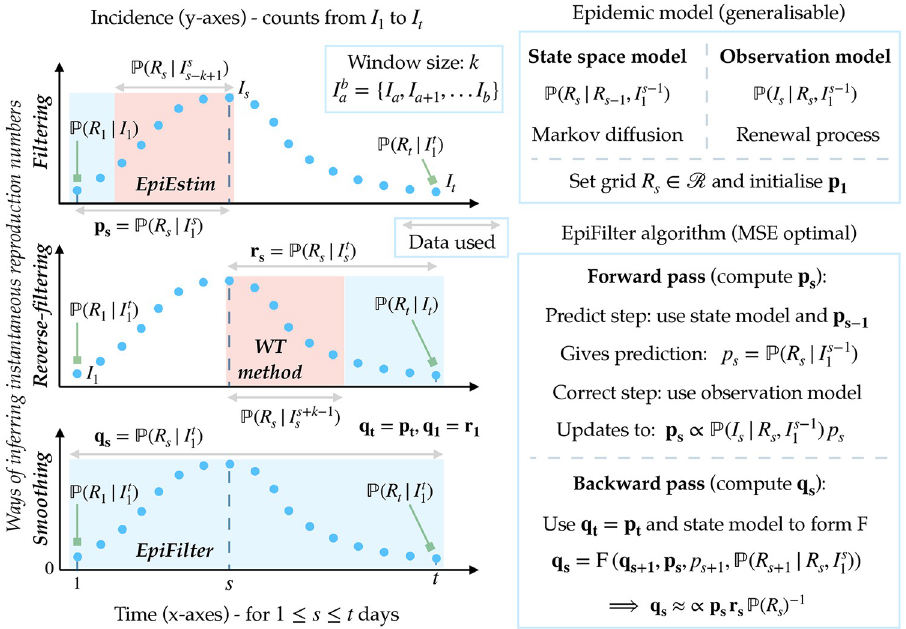
Fig 1. EpiFilter algorithm and relationship to other methods. In the left panels we consider three ways of inferring the instantaneous or effective reproduction number at time s , R s , from the incidence curve, I t (blue dots). The filtering 1 solution produces the posterior distribution p s from all data prior to time s . EpiEstim approximates this solution by using the subset of data in a window of size k into the past. Reverse-filtering considers the complementary part of the incidence curve, leading to r s , which utilises data beyond s . The WT method, with future window k , approximates this type of solution. Smoothing uses all information from I t to generate q s , which is precisely computed by EpiFilter. Blue 1 that inform on R s for each of p s , r s and q s while red windows highlight the subsets windows show the portions of I t 1 used by EpiEstim and the WT method. Double arrows indicate data used for constructing various posterior distributions, while square arrows pinpoint instances of those distributions at the edges of I t . In the right panels we 1 summarise the construction of EpiFilter. We outline the main assumptions (the model box) and computations (the algorithm box) necessary for realising EpiFilter, which allow us to obtain the most informative and minimum mean squared error (MSE) smoothing posterior distribution q s . See the main text for the specific equations employed in our implementation